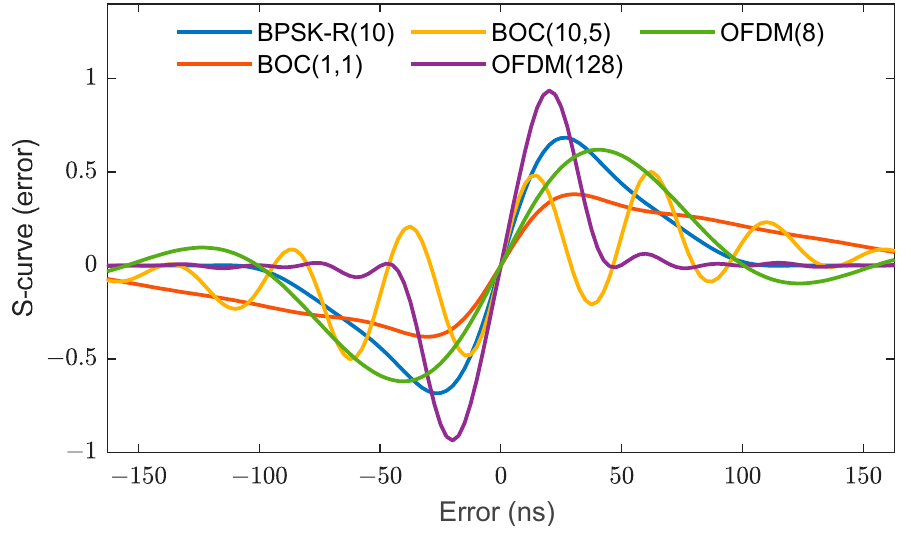
Figure 12. Code tracking ring S-curve.